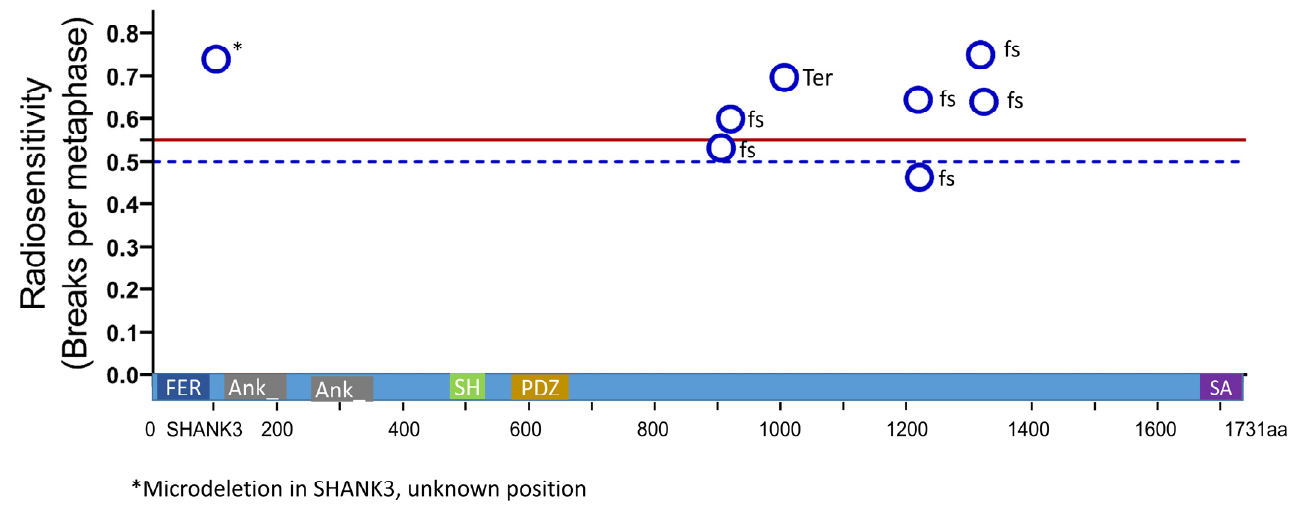
Figure 3. Location of pathogenic variants in the SHANK3 gene in eight patients with PMS and associated radiation sensitivity expressed as breaks per metaphase. The location of the variants in the SHANK3 gene of eight individuals with PMS is indicated by blue rings. The height indicates the associated radiation sensitivity (fs = frameshift mutation and Ter = termination mutation). The mutation marked by an asterisk is a microdeletion in the SHANK3 gene with unknown location. The dashed blue line indicates individuals with increased radiation sensitivity and the solid red line indicates individuals with significantly increased radiation sensitivity.